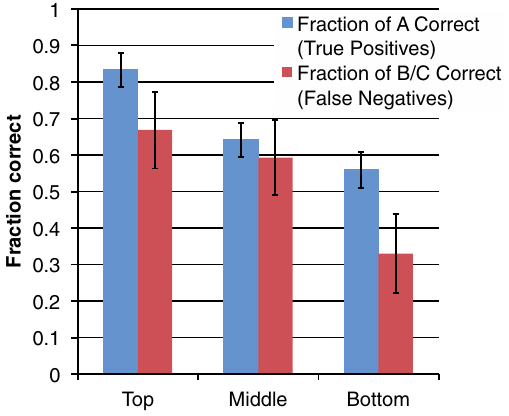
FIG. 6. Average fraction of KS questions to which students had responded A or B or C which they then went on to answer correctly, broken out by student groupings based on overall final exam score for Chemistry 110. Error bars represent the 95% con- fidence interval of the